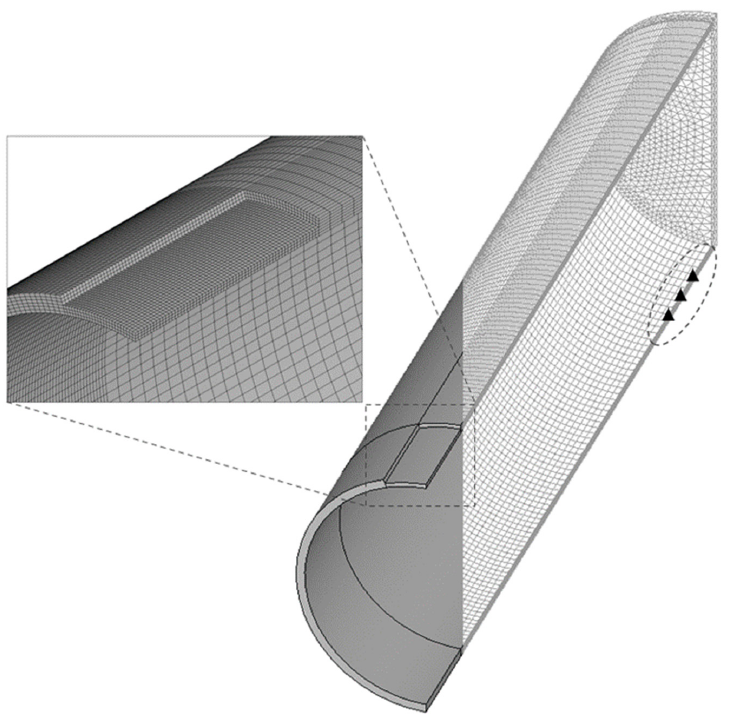
Figure 3. Pipe model meshed with elements.